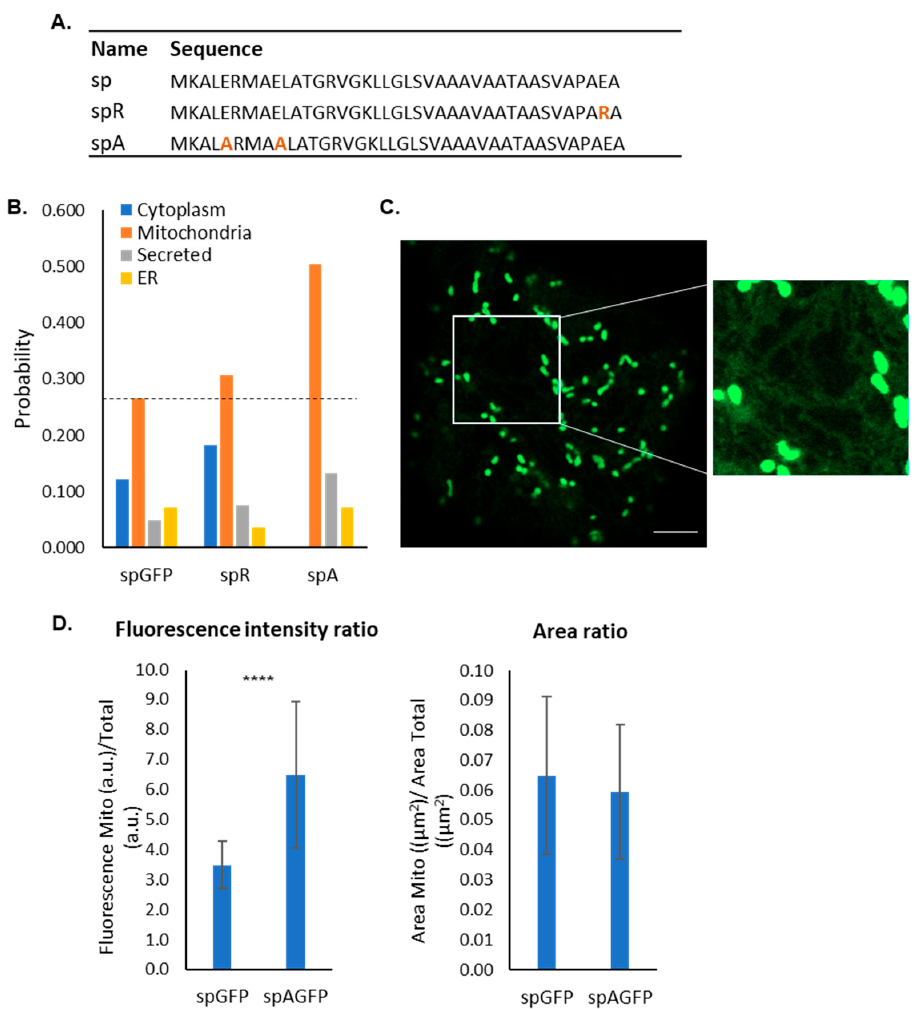
Figure 4. Mitochondrial import efficiency of glutamate to alanine mutations. ( A ) Sequences of spR and spA with mutated residues highlighted in orange. ( B ) Probability of mitochondrial localisation predicted using MULocDeep. ( C ) Example cell expressing spA-GFP showing strong labelling of mitochondria with a low background. Inset shows faint ER labelling. ( D ) Quantification of the ratio of mitochondria to total fluorescence in sp-GFP and spA-GFP (Mann–Whitney U test, p -value < 2.2 × 10 − 16 , n = 60 cells), and quantification of the ratio of mitochondrial area compared to total cell area of the same group of cells (Mann–Whitney U test, p -value = 0.2336). **** = p -value < 0.0001. Scale bar = 5 μ m.